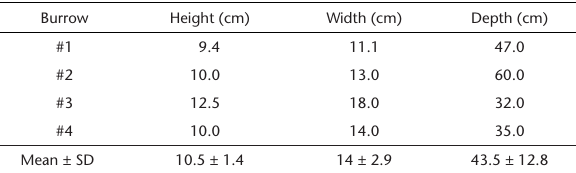
Table 2. Measurements of burrows of Tolypeutes tricinctus kept in semi-captivity at Reserva Natural Serra das Almas, Crateús,